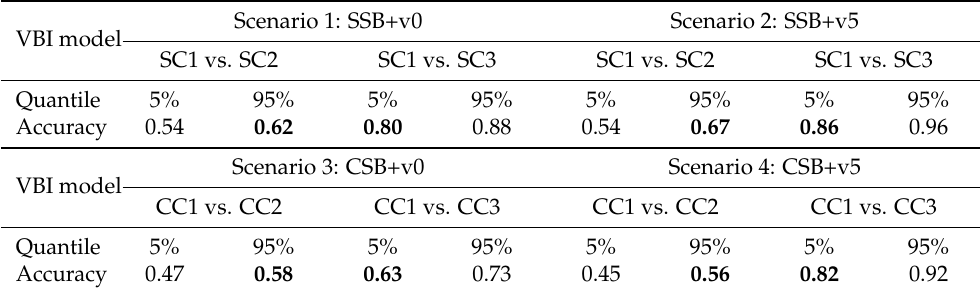
Figure 15. Classification accuracy values using MDS. Table 7. Quantiles of accuracy values using